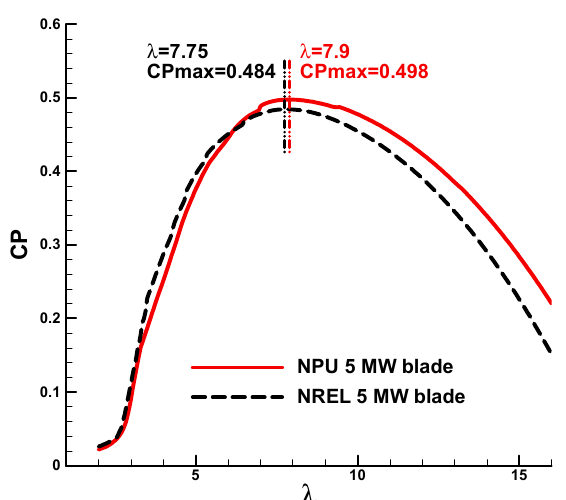
Figure 21. Comparison of power tip-speed ( λ ) ratio–coefficient (CP) for the NPU and NREL 5 MW blades.